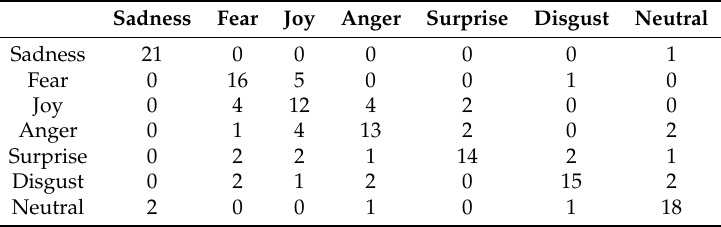
Table A4. P4 actor confusion matrix from the RekEmozio dataset in the second